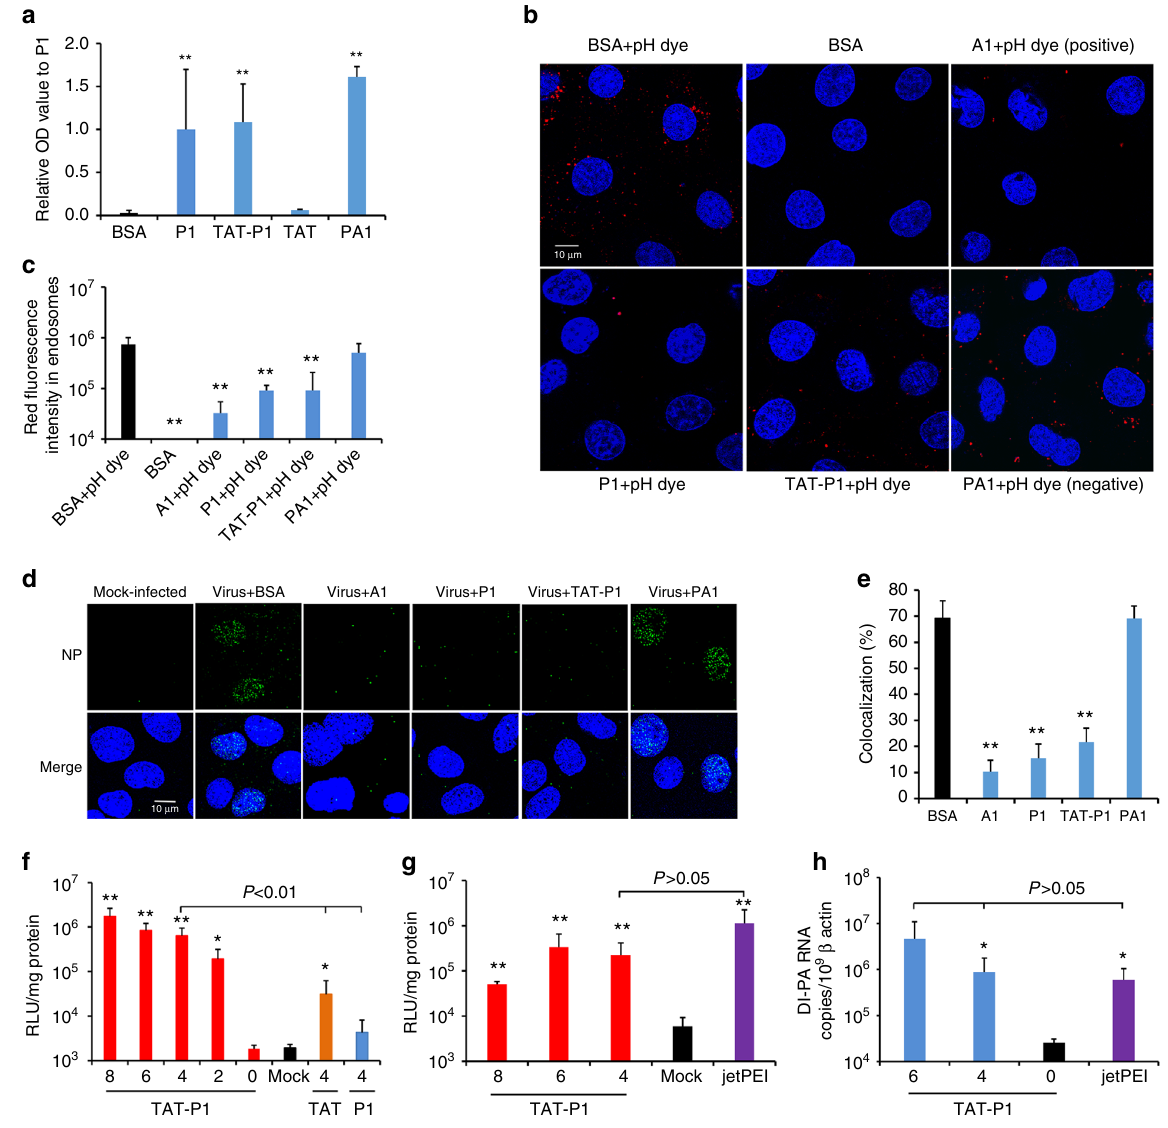
Fig. 4 The antiviral mechanism and transfection ef fi ciency of TAT-P1. a P1 and TAT-P1 could bind to H1N1 glycoprotein HA1 in an ELISA assay. OD values were normalized to P1 as 1. ** Indicates P < 0.01 when compared with BSA. b P1 and TAT-P1 could prevent endosomal acidi fi cation. Red dots (pHrodo TM dextran) indicate pH lower than 6.0 in endosomes. P9-aci-1 (PA1), which did not prevent endosomal acidi fi cation, was a negative peptide control for P1. Blue color indicates nuclei. Live cell images were taken by confocal microscope (original magni fi cation ×400, scale bar = 10 μ m). c The quanti fi cation of red fl uorescence of endosomal acidi fi cation in MDCK cells when cells were treated by BSA, ba fi lomycin A1 (A1), P1, TAT-P1, or PA1 corresponding to b . Ten microscope fi elds of each sample were included for quanti fi cation. ** Indicates P < 0.01 when compared with BSA + pH dye group. d P1 and TAT-P1 could prevent viral RNP release into nuclei. MDCK cells were infected with 1 MOI of A(H1N1) virus treated with or without drugs. Images of NP (green) and nuclei (blue) were taken at 3.5 h post infection (scale bar = 10 μ m). e Percentages of NP colocalized to nuclei. The SD was determined from multiple microscope fi elds including ~ 200 cells for each sample. ** Indicates P < 0.01 when compared with BSA. f Transfection ef fi ciency of peptide/pLuc in 293T cells. Numbers indicate weight ratios of corresponding peptide:pLuc. Mock means cells treated with TAT-P1 without DNA. Data were presented as mean ± SD of three independent experiments. g Transfection ef fi ciency of pCMV-Luc transfected by TAT-P1 or jetPEI in mouse lungs. Luciferase expression in mouse lungs was normalized to 1 mg protein. Mock means mice treated with TAT-P1 or jetPEI without DNA. h Transfection ef fi ciency of plasmid of DI- PA transfected by TAT-P1 or jetPEI in mouse lungs. Data were presented as mean ± SD of ≥ 3 mice in each group. * Indicates P < 0.05. ** Indicates P < 0.01 when compared with Mock in f and g or when compared with “ 0 ” (naked DNA) in h . P values were calculated by the two-tailed Student ’ s t when compared with mice treated with PBS. IL-6 was signi fi cantly lower in mice treated by TAT-P1/DIG-3 than that in mice treated by jetPEI/DIG-3. TAT-P1/DIG-3 protects mice from A(H1N1)pdm09 virus infection . To evaluate the antiviral ef fi cacy of TAT-P1/DIG-3 against seasonal in fl uenza virus, the prophylactic and therapeutic